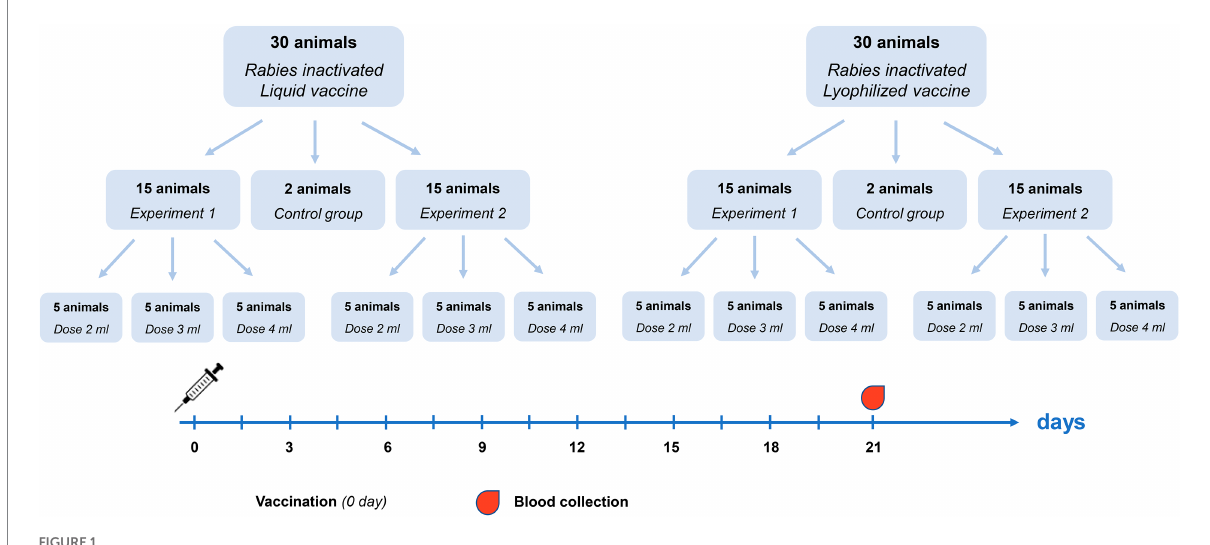
FIGURE 1 Vaccine dose determination experiment